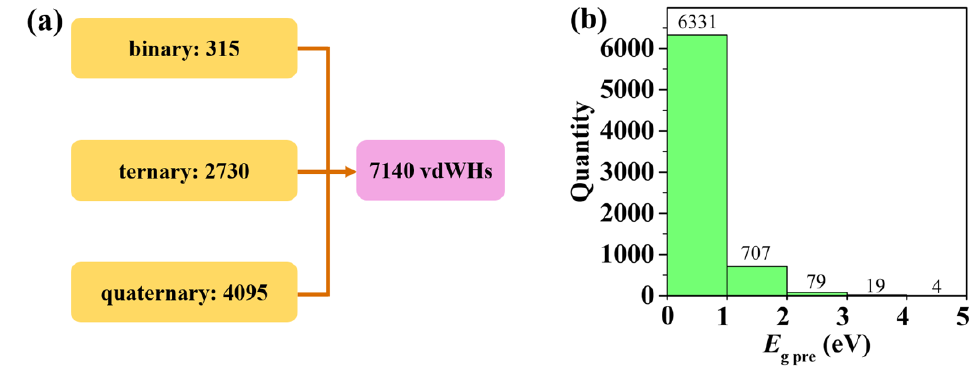
Figure 3. ( a ) Schematic illustration of 7140 AB/CD vdWHs, which includes 315 binary, 2730 ternary, and 4095 quaternary systems. ( b ) Distribution of 7140 vdWHs according to their SISSO-predicted band Table 2. Comparisons of the SISSO-predicted band gaps and those calculated by first-principles (HSE scheme), for six randomly selected vdWHs beyond the original dataset.